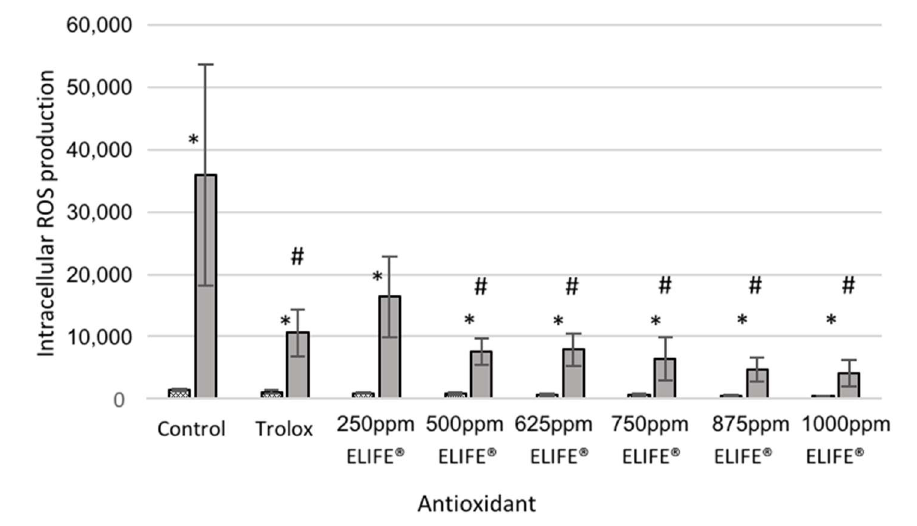
Figure 5. ROS production after an 18-h pre-incubation with: control (colorless growth medium containing no antioxidant), trolox (colorless growth medium containing 2 mM trolox) and different concentrations of ELIFE ® , followed by a one-hour incubation with medium (colorless growth medium containing no stressors, dotted bars) or 200 µM menadione (in colorless growth medium, solid grey bars). ROS production in different conditions was determined by fluorescence measurement (measured in arbitrary units, AU). Different asterisks (*) indicate statistically significant differences in ROS production in non-stressed and menadione-treated cells (i.e., stressor effect). Hashtags (#) represent a statistically significant decrease in ROS production after incubation with ELIFE ® /trolox when compared to control cells (antioxidant effect). Data represent means ± SD ( n = 3). p < 0.05.